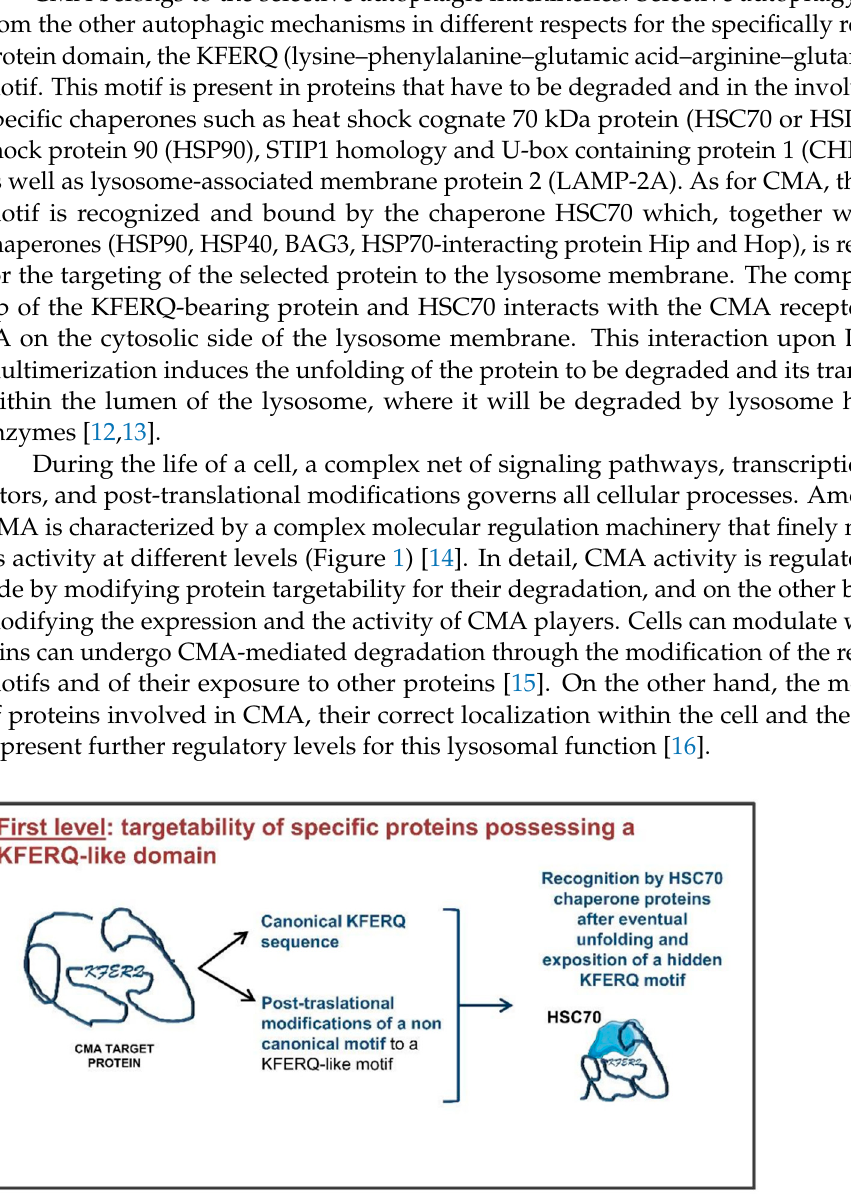
Figure 1. Schematic representation of the multi-level CMA (chaperone-mediated autophagy) regu- lation machinery. Panel 1: The first regulatory level is based on the availability and accessibility of the KFERQ motif. Non-canonical motifs can be modified to be recognized by chaperone proteins. HSC70 chaperone delivers specific proteins to the lysosome. Panel 2: The second regulatory level depends on LAMP-2A quaternary structure. Its trafficking in the lysosomal membrane is finely reg- ulated. Moreover, unphosphorylated GFAP (GFAP) stabilizes the LAMP-2A multimer, favoring the translocation of unfolded proteins within the lysosomes. When GFAP is present in its phosphory- lated form (GFAP-P), it interacts with EF-1 α , determining the disassembling of LAMP-2A multi- mers. In addition, LAMP-2A de novo expression can be regulated by the transcription factor NRF-2. Panel 3: The third regulatory level is due to the availability of accessory proteins among which the main regulator is PHLPP1. It is a phosphatase influencing the activity of other proteins. Rac-1 bound to PHLPP1 favors its activity on AKT. Inactive AKT is not able to phosphorylate GFAP allowing LAMP-2A multimer stabilization. A protein, to be a CMA target, must contain a pentapeptide biochemically correlated to the sequence “KFERQ”, as this motif works as a recognition sequence for chaperone proteins. To be functional, this motif should contain a glutamine (Q) on one side, two